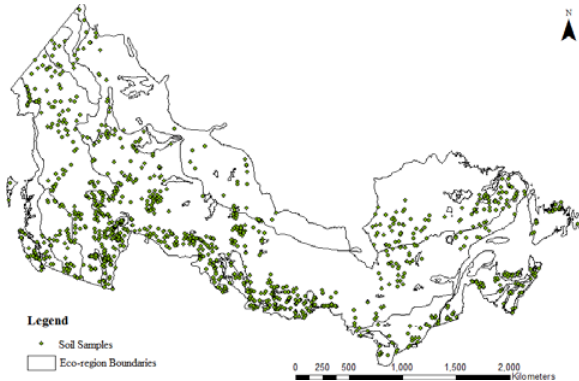
Figure 2. The spatial distribution of 1,317 CFS soil samples collected in Canadian forest areas before 1991 by the Canada Forest